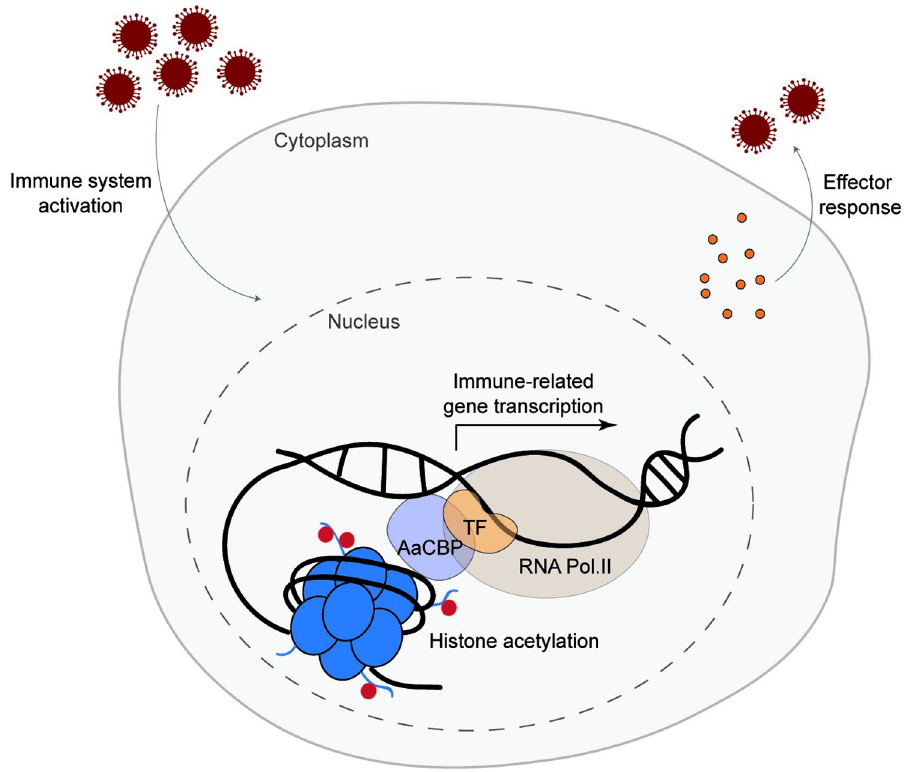
Fig 6. Proposed model for the role of AaCBP-mediated histone acetylation in suppressing ZIKV infection in A . aegypti . Zika infection signals the functional activation of transcription factors (TF) that translocate to the nucleus where they activate the expression of immune-related genes to fight the virus infection. Chromatin decondensation is mandatory for gene activation. Therefore, AaCBP is likely recruited by TFs to target promoters, where it exerts its histone acetyltransferase activity, leading to an open state of the chromatin at these promoter sites.